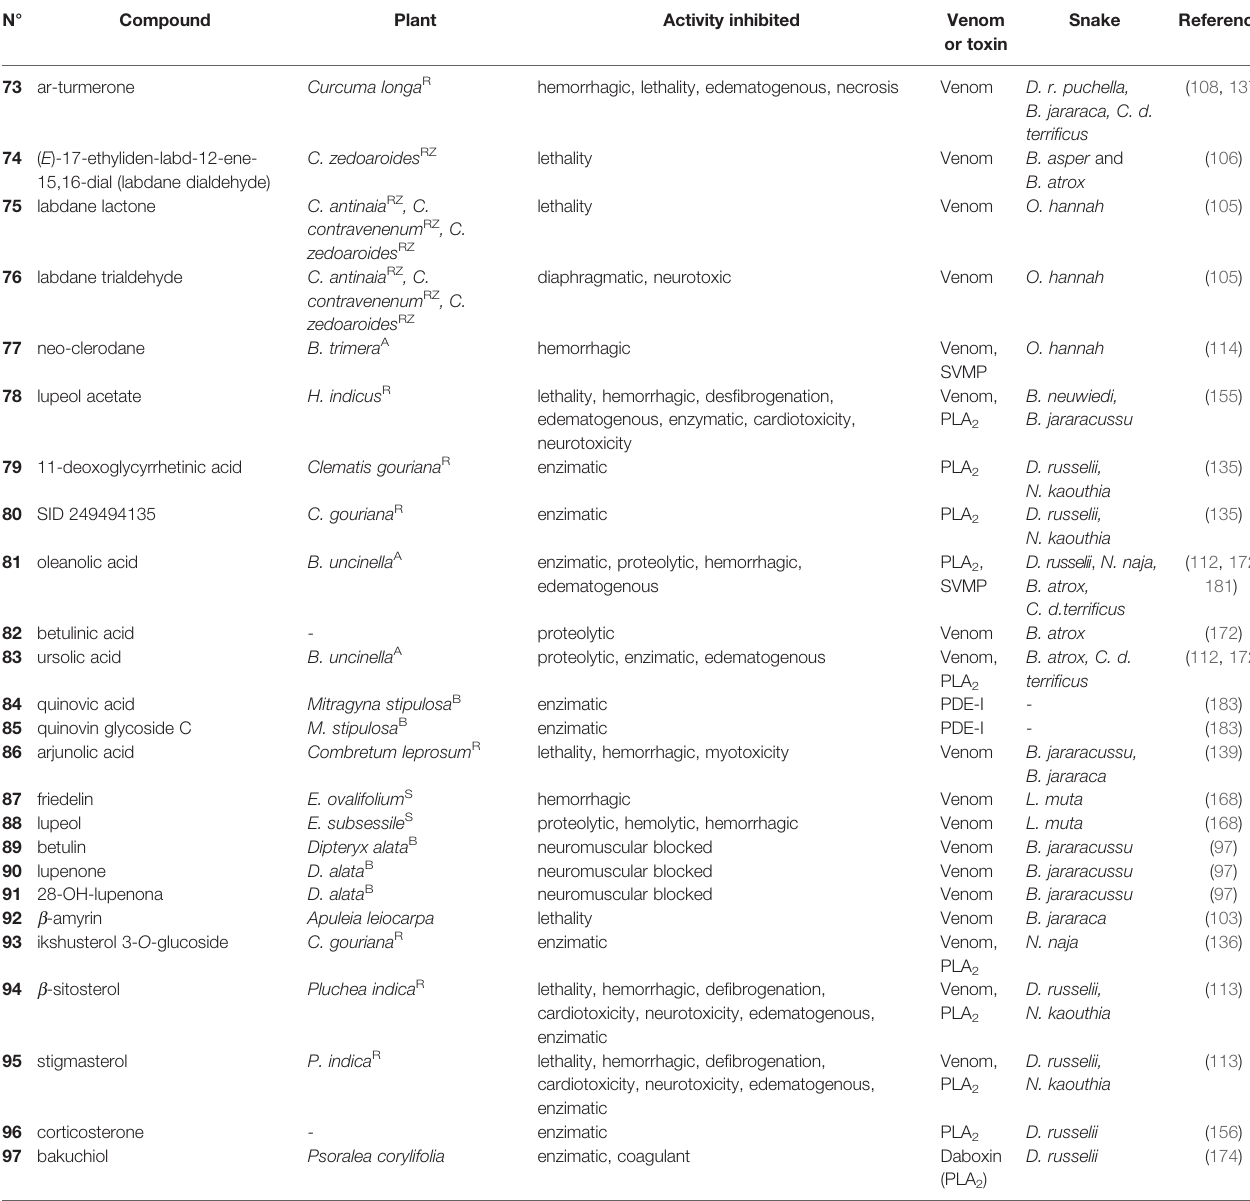
TABLE 5 | Terpenes (73-97) with antivenom